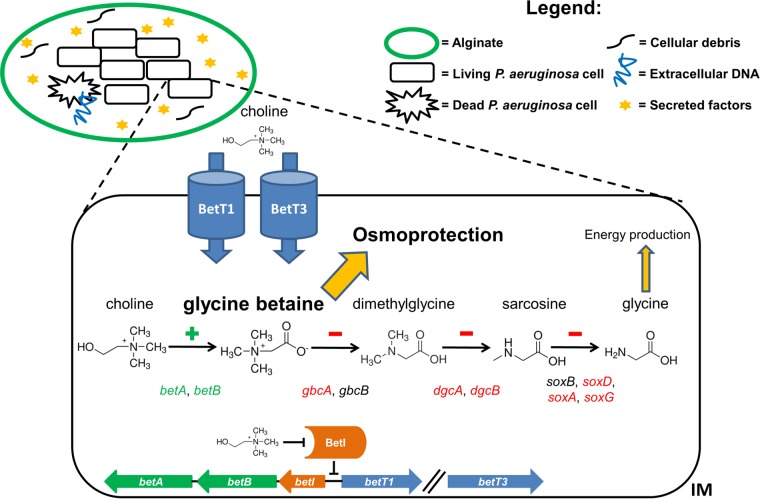
Hypothetical model of the adaptation of P. aeruginosa CF_PA39 to the low fluid shear conditions at the level of osmoprotection. Under the low fluid shear conditions, P. aeruginosa forms biofilms of closely associated cells that are surrounded by alginate layers. The production of several secreted molecules, as well as extracellular DNA and cell debris from dying cells, creates a local hyperosmotic environment. In order to protect itself against this hyperosmotic condition, P. aeruginosa imports choline via the BetT1 and BetT3 transporters, thereby releasing repression of the betIBA operon (and of choline transporter genes betT1 and betT3) by the BetI repressor, and switches on the genes that are required for glycine betaine biosynthesis, using choline as a substrate. At the same time, the majority of genes involved in the catabolism of glycine betaine to glycine are downregulated, leading to an accumulation of the osmoprotectant glycine betaine. Genes highlighted in green were found to be upregulated whereas genes highlighted in red were found to be downregulated under low fluid shear versus high fluid shear conditions. The genes involved in the biosynthetic process proceeding from choline to glycine betaine are shown at the bottom. Glycine betaine biosynthetic genes betA and betB are shown in green, the betI repressor gene is shown in orange, and the choline transporter genes are shown in blue. The BetI protein is represented by an orange open cylindrical shape. The // symbol indicates that this gene is located at a distant position in the genome. IM, inner membrane.